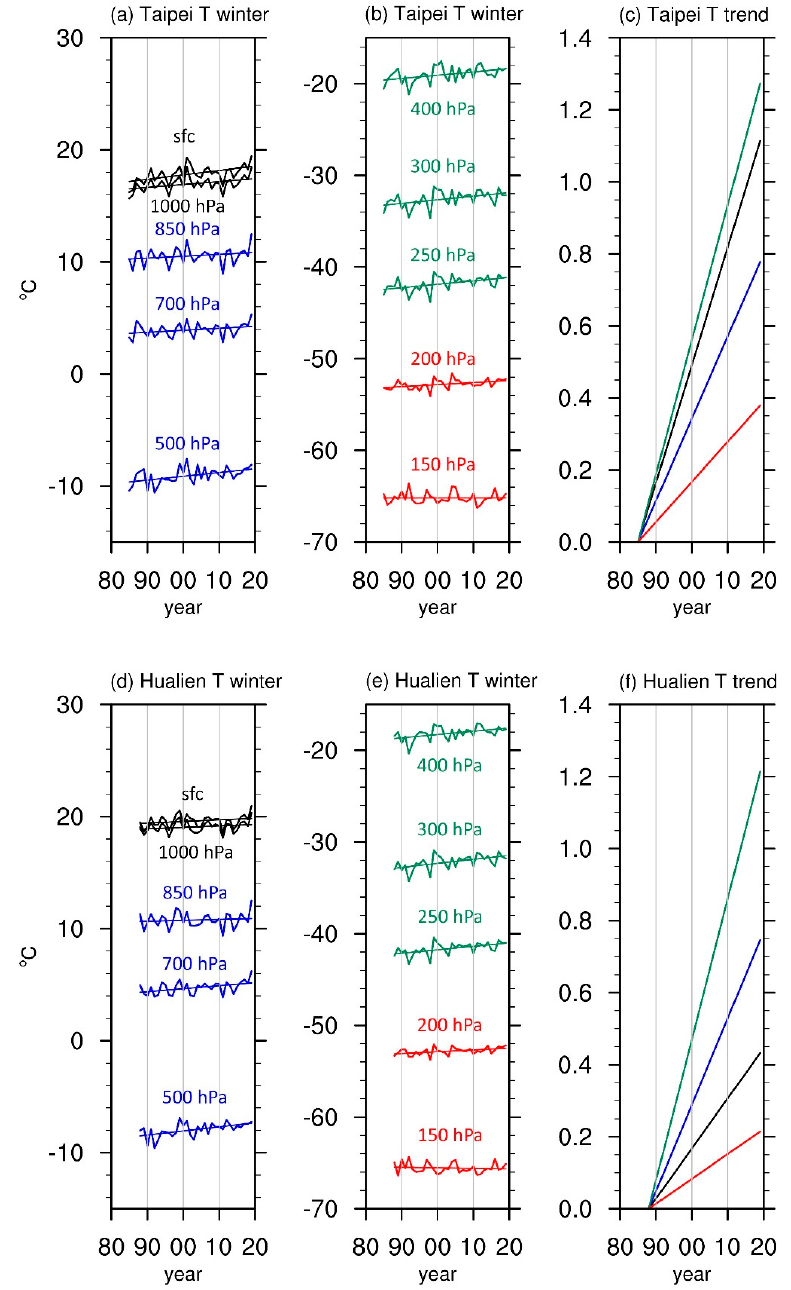
Figure 5. Same as Figure 4 but for the winter mean temperature from November to next April. The result of the winter half in Hualien also reveals a bigger temperature jump than the annual mean between 400 hPa and 250 hPa over the past decades, with a warming rate of 0.35 °C per decade and uncertainty (standard error) ranges between 0.0112 °C and 0.013 °C. It also shows much more prominent warming than the other layers, including the group of the surface and 1000 hPa, with a warming rate of 0.13 °C per decade and uncertainty (standard error) ranges between 0.0098 °C and 0.01 °C, the group of 850 hPa